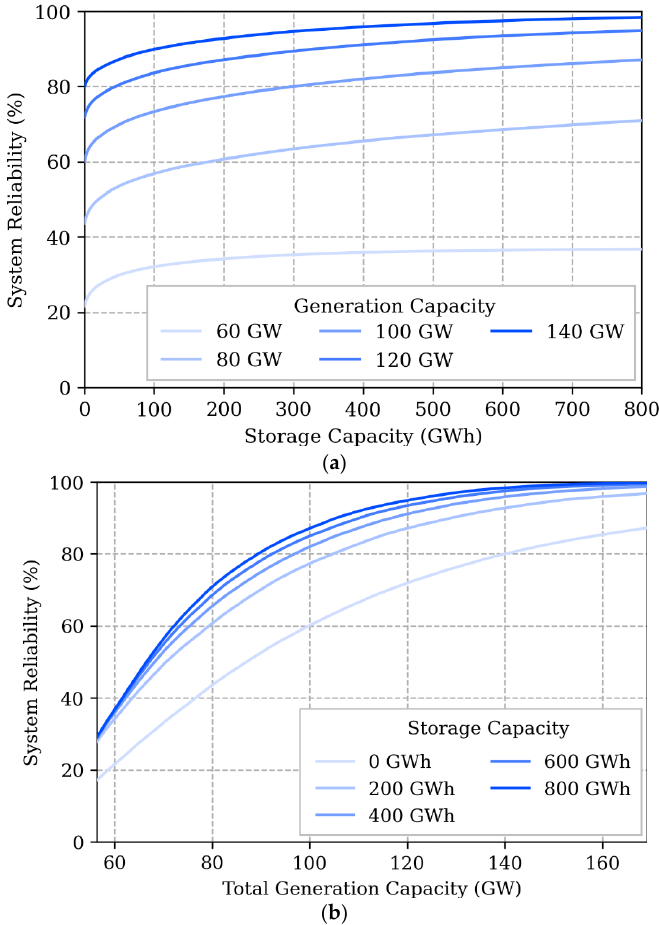
Figure 3. System reliability for a range of total system generation and storage capacities: ( a ) variation in system reliability with storage capacity, for five levels of generation capacity; ( b ) variation in system reliability with generation capacity, for five levels of storage capacity. Each system is made up of 40% offshore wind, 30% onshore wind and 30% solar